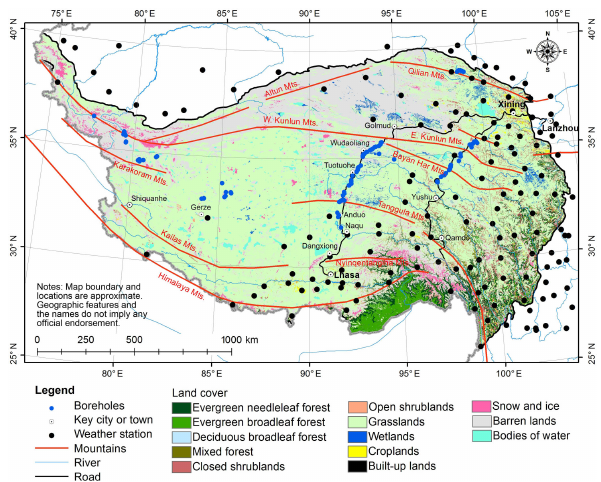
Figure 1. The distribution of in situ MAAT observation stations and MAGT boreholes over the